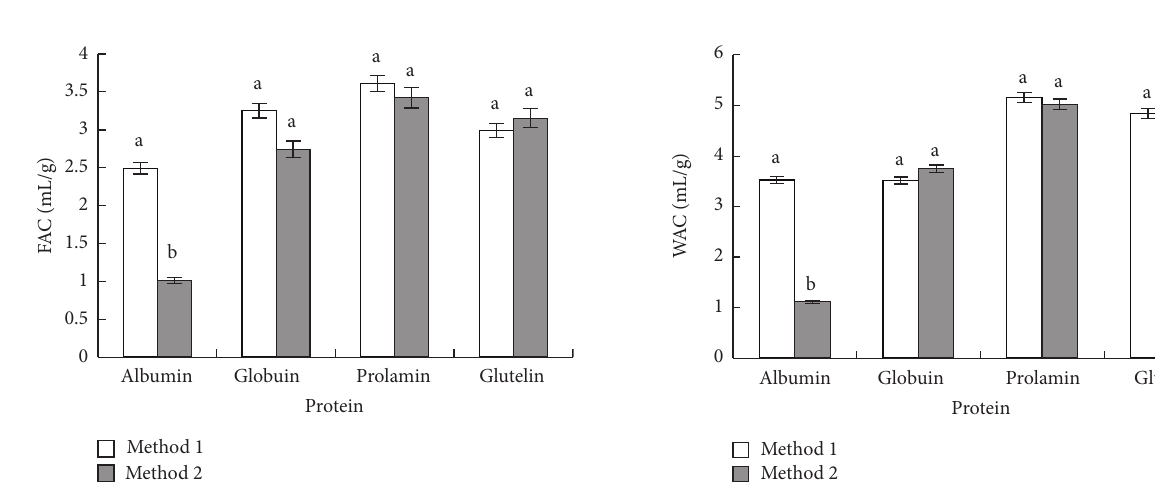
Figure 5: FAC of FRBPs prepared by the two extraction methods.